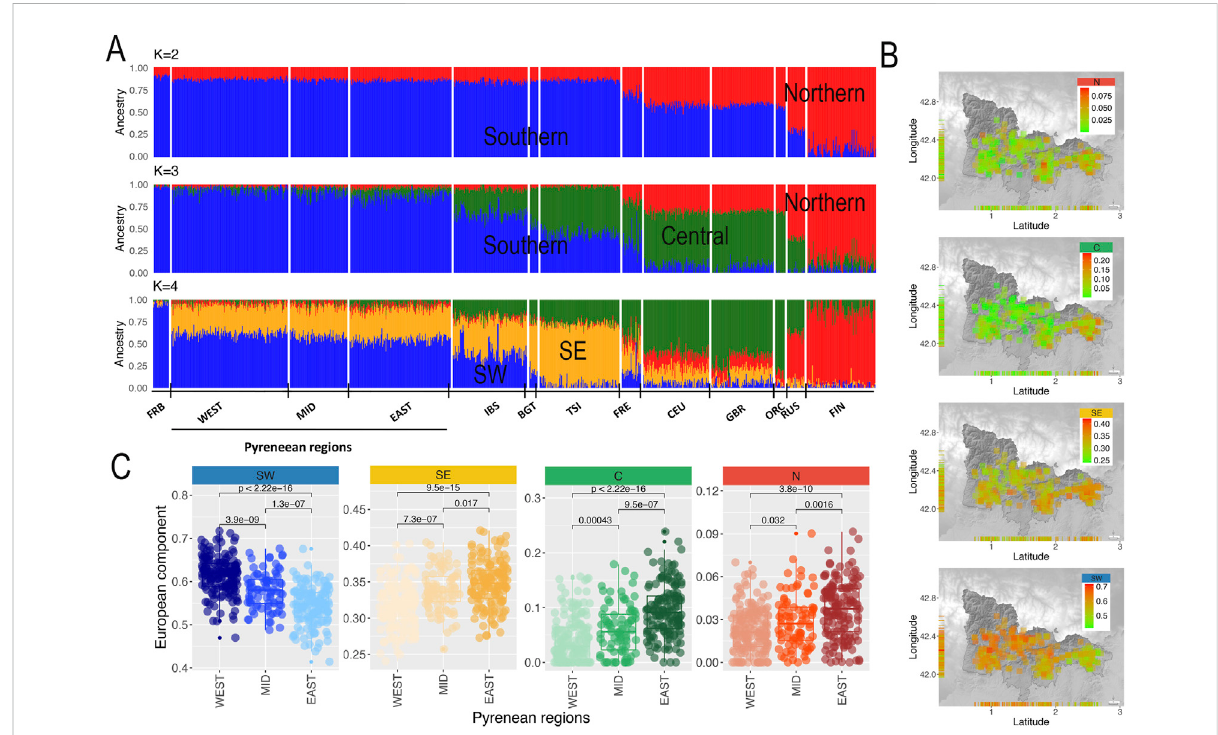
FIGURE 3 (A) AdmixtureanalysisofEuropeanpopulationsandcatalanPyreneanpopulationsforK=2toK=4.AtK=2weshowedaNorth(N)toSouth(S) gradient component in the European samples (red and blue labeled, respectively). At K = 3 a newly component appears that should be assigned to Central (C) European component (green labeled). Finally, at K = 4 the Southern component splits into a Southeastern (SE) component (orange labeled) and a Southwestern (SW) component (green labeled). (B) Distribution of European components K = 3 (N, C) and K = 4 (SE, SW) on GENPIRindividualsamplesaccordingtotheirgeographicallocation. (C) BoxplotdistributionofEuropeancomponentsK=3(N,C)andK=4(SE,SW) in the West ( n = 168), Mid ( n = 83) and East ( n = 146) catalan Pyrenean regions, including p -values of pairwise t -test